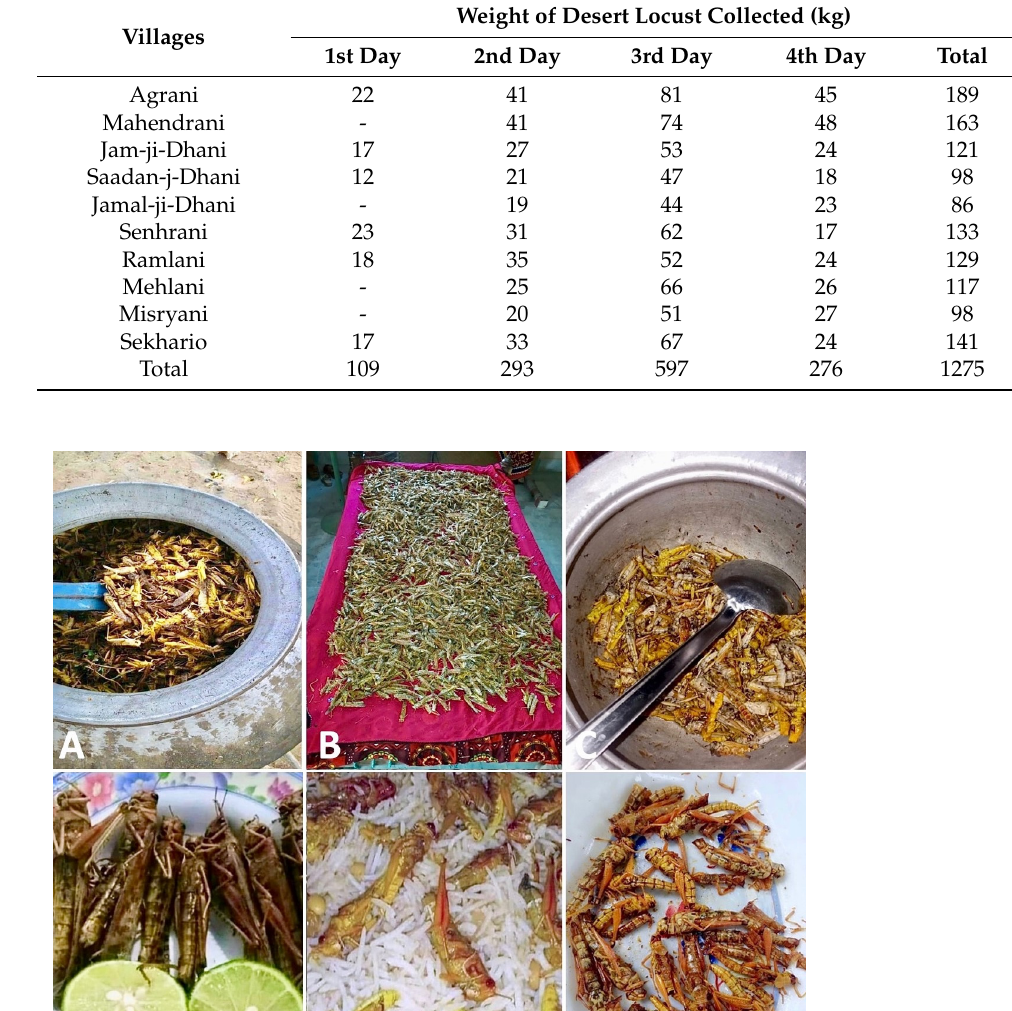
Table 1. Collection of desert locust by villagers after the arrival of the first swarm on 4 July 2019.